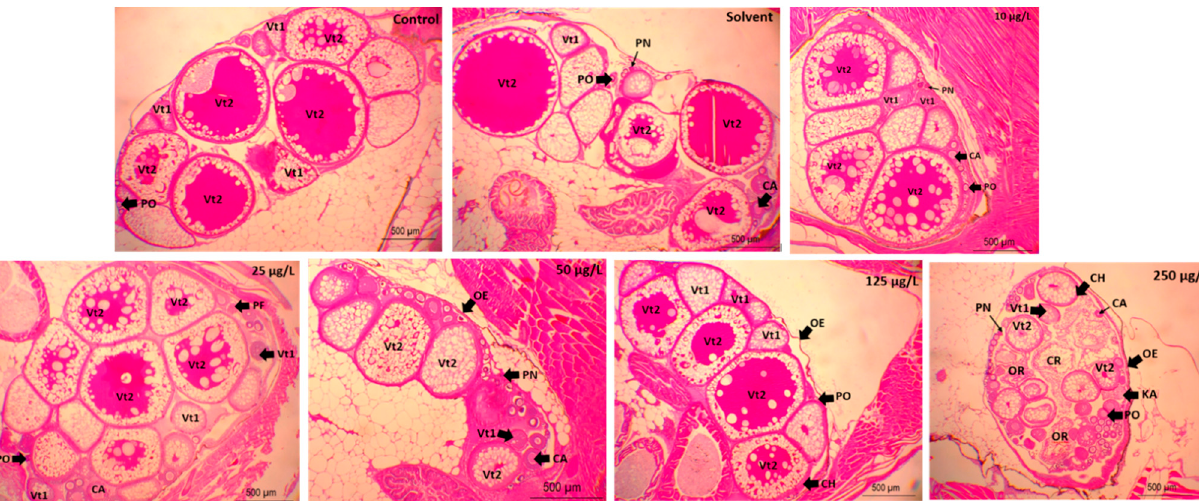
Figure 3. Microphotograph (H&E stained, ×40) of Javanese medaka ovaries at 21 days post-exposure to sublethal concentration of 3,4-DCA. AO, atretic oocyte OE, ovarian epithelium; BV, blood vessels; PF, primordial follicle; LF, large follicle; GR, granulosa cell; OC, ovarian cavity; OE, ovarian epithelium; OC, ovarian cavity; GF, growing follicle; LF, large follicle; CH, chorion; DM, Vt1, primary vitellogenic oocyte; Vt2, secondary vitellogenic oocyte, PN, perinucleolar oocytes; CA, cortical alveolar oocytes; PF, postovulatory follicle. Table 3. Gonadal staging and ovarian lesions (n = 3) in Javanese medaka at 21 days post-exposure to 3,4-DCA. Staging (Median) Lesions (%) Treatment ( µ g/L) Atretic OOCYTE Oocyte Retraction Karyoptic Clumping